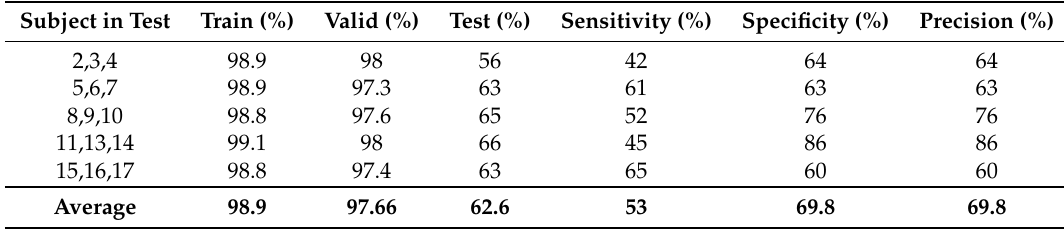
Table 8. The accuracy measures for the generic models using frequency domain